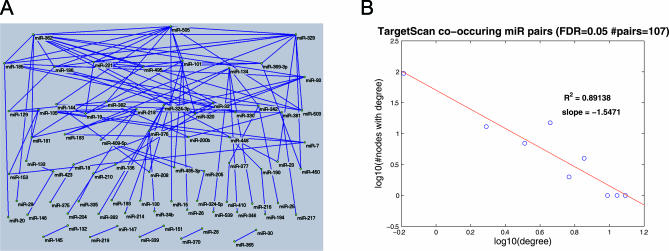
miR Co-Occurrence Network in the TargetScan Dataset(A) The TargetScan miR co-occurrence network, at FDR level of 0.05. A node represents a miR and an edge connects between pairs of miRs with significant rate of co-occurrence. The nodes in the figure are arranged from most highly connected on the top, to most lowly connected, on the bottom. For interactive viewing of the network, using Pajek (http://vlado.fmf.uni-lj.si/pub/networks/pajek/), see Datasets S1 and S2.(B) Degree distribution in the TargetScan miR combinatorial regulation network (co-occurring miR pairs that passed FDR of 0.05).